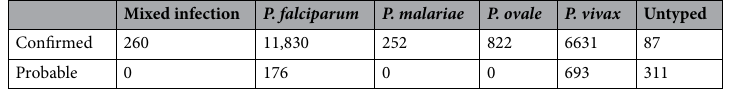
Table 4. Cases by diagnosis type (probable and confirmed) and species across China.